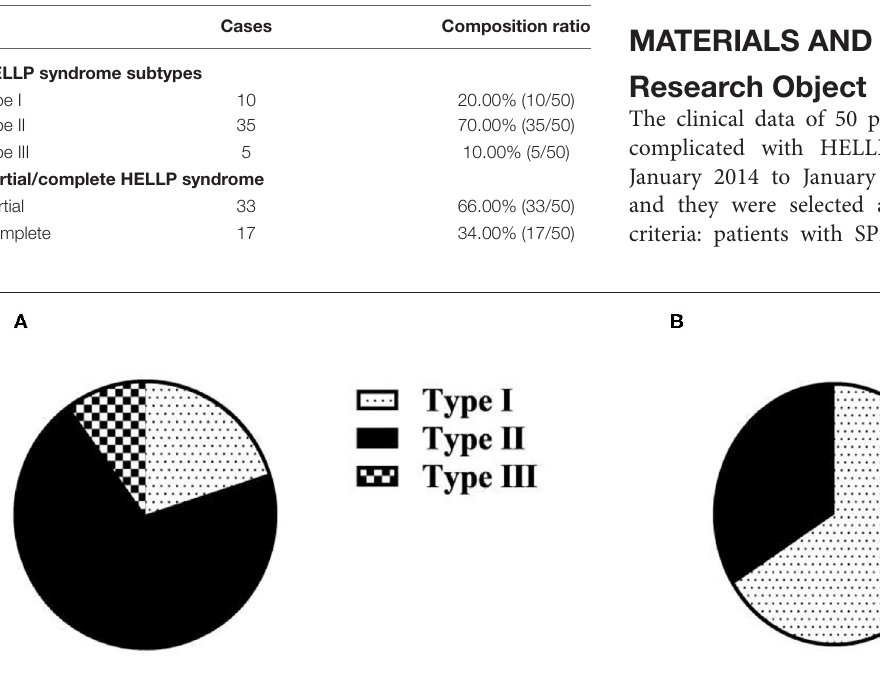
FIGURE 1 | Clinical classification composition ratio of 50 maternities in the observation group ( n , %). (A) Clinical classification based on PLT; (B) Clinical classification based on complete/partial